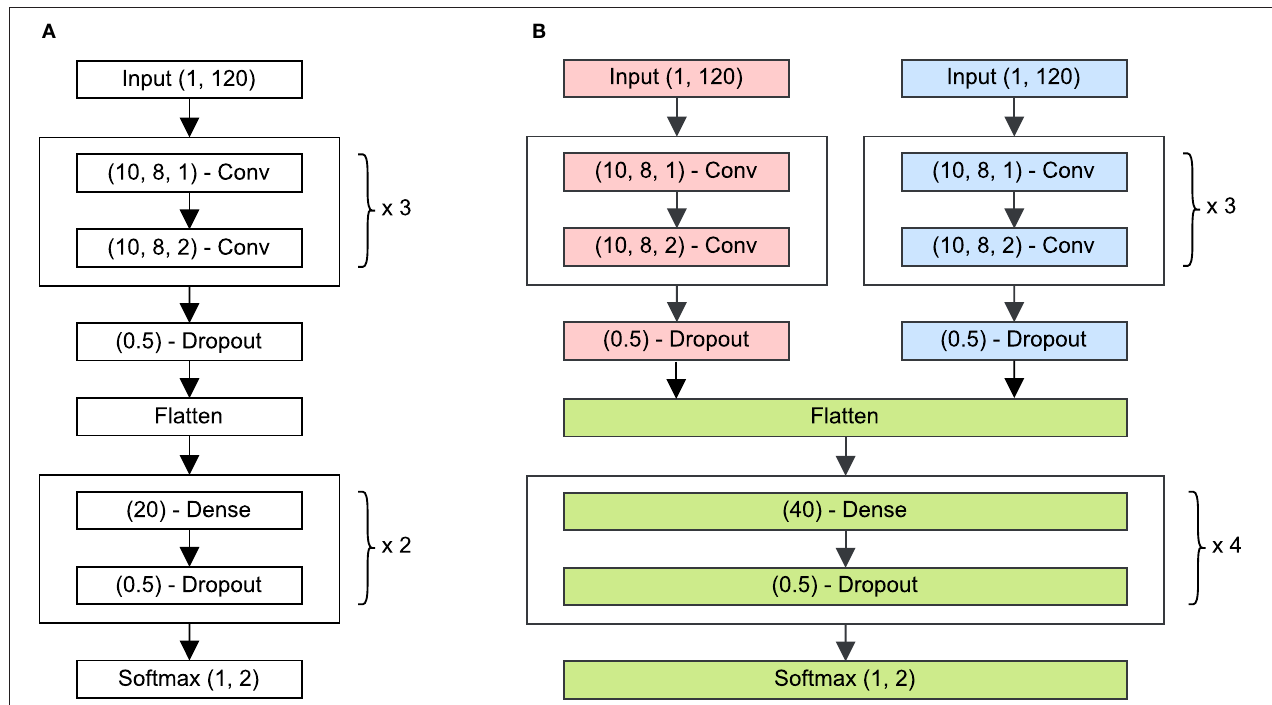
FIGURE 2 | (A) Illustration of the network architecture used for the cardiac and the respiratory signals separately. This CNN extracted characteristics from the input epoch with length 120 samples. The layer ( f , k , s ) − Conv indicates a layer with f filters, kernel size l and stride s , and an activation of type ReLu . After the convolutional block, dense layers, ( n ) − Dense , with n neurons were included. A third type were dropout layers, ( d % ) − Dropout , where d % = 50 % of the weights were equal to zero in every training step to avoid overfitting. The output layer is a softmax layer, Softmax(1,c) , delivering posterior class probabilities for every one of the c = 2 classes, where class 0 represented Sleep and class 1 Wake. (B) Architecture of the combined deep learning network, consisting of a cardiac CNN (red), a respiratory CNN (blue) and a combined dense network (green). During training, the weights of convolutional branches were frozen, while the dense layers were